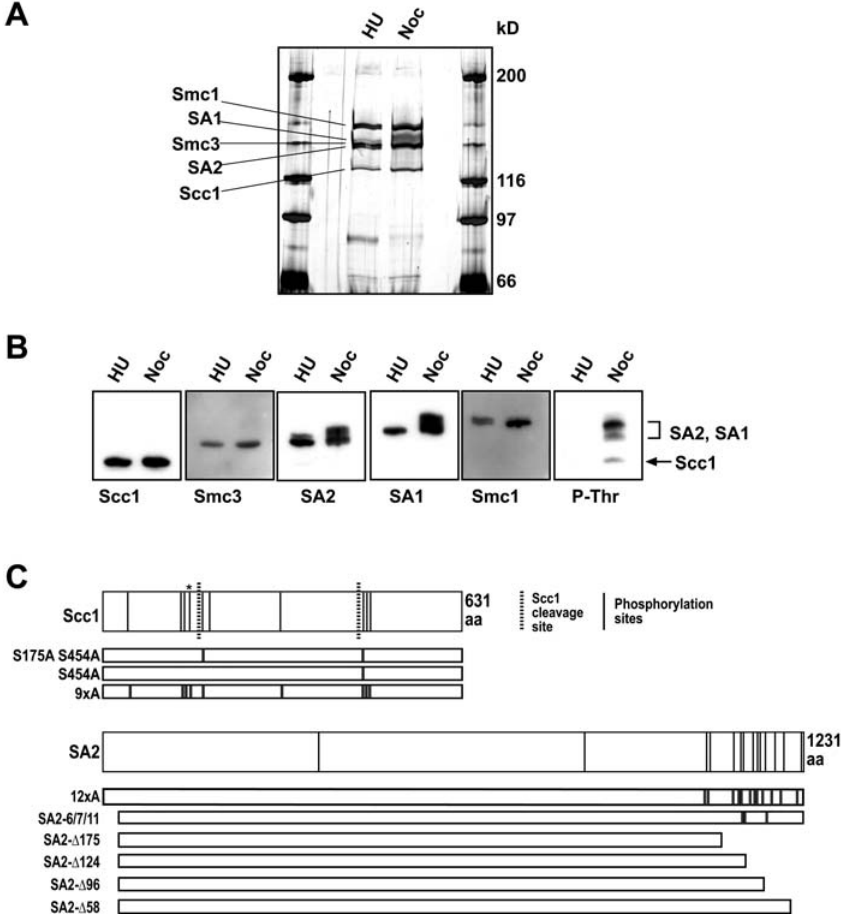
Figure 1. Identification of Mitosis-Specific Phosphorylation Sites on Human Cohesin (A and B) Cohesin was immunoprecipitated by antibody 447 (which recognizes SA1 and SA2) from extracts prepared from HeLa cells that were either arrested in S-phase by hydroxyurea (HU) or in mitosis by nocodazole (Noc). Cohesin was eluted by buffer of low pH and analyzed by (A) silver staining and (B) immunoblotting with antibodies to cohesin subunits and phosphorylated threonine (P-Thr). (C) Schematic representation of the phosphorylation sites on Scc1 and SA2 that were identified by mass spectrometry, and of the mutant versions of the proteins that have been generated. The star indicates a phosphorylation site that was found in both interphase and mitotic Scc1. All SA2 constructs used for in vitro experiments lack the 69 N-terminal amino acids. SA2-WT-myc and SA2–12xA-myc cell lines contain the entire open reading frame of 1,231 amino acids. DOI: